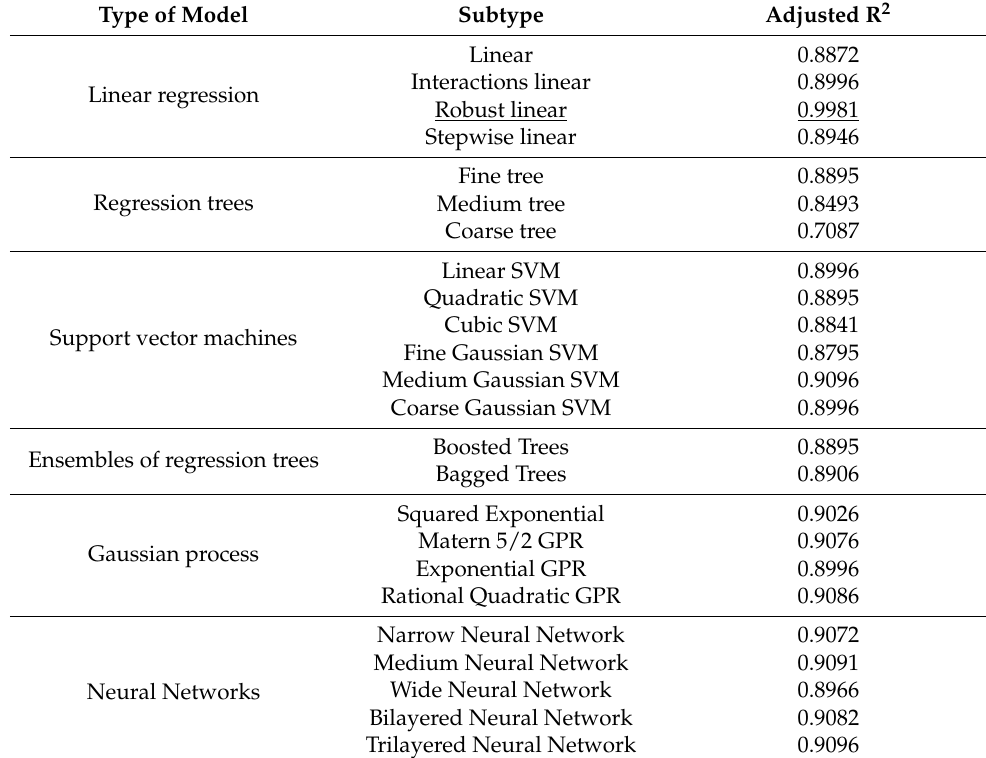
Table 5. Results from regression models testing with the whole new tractors